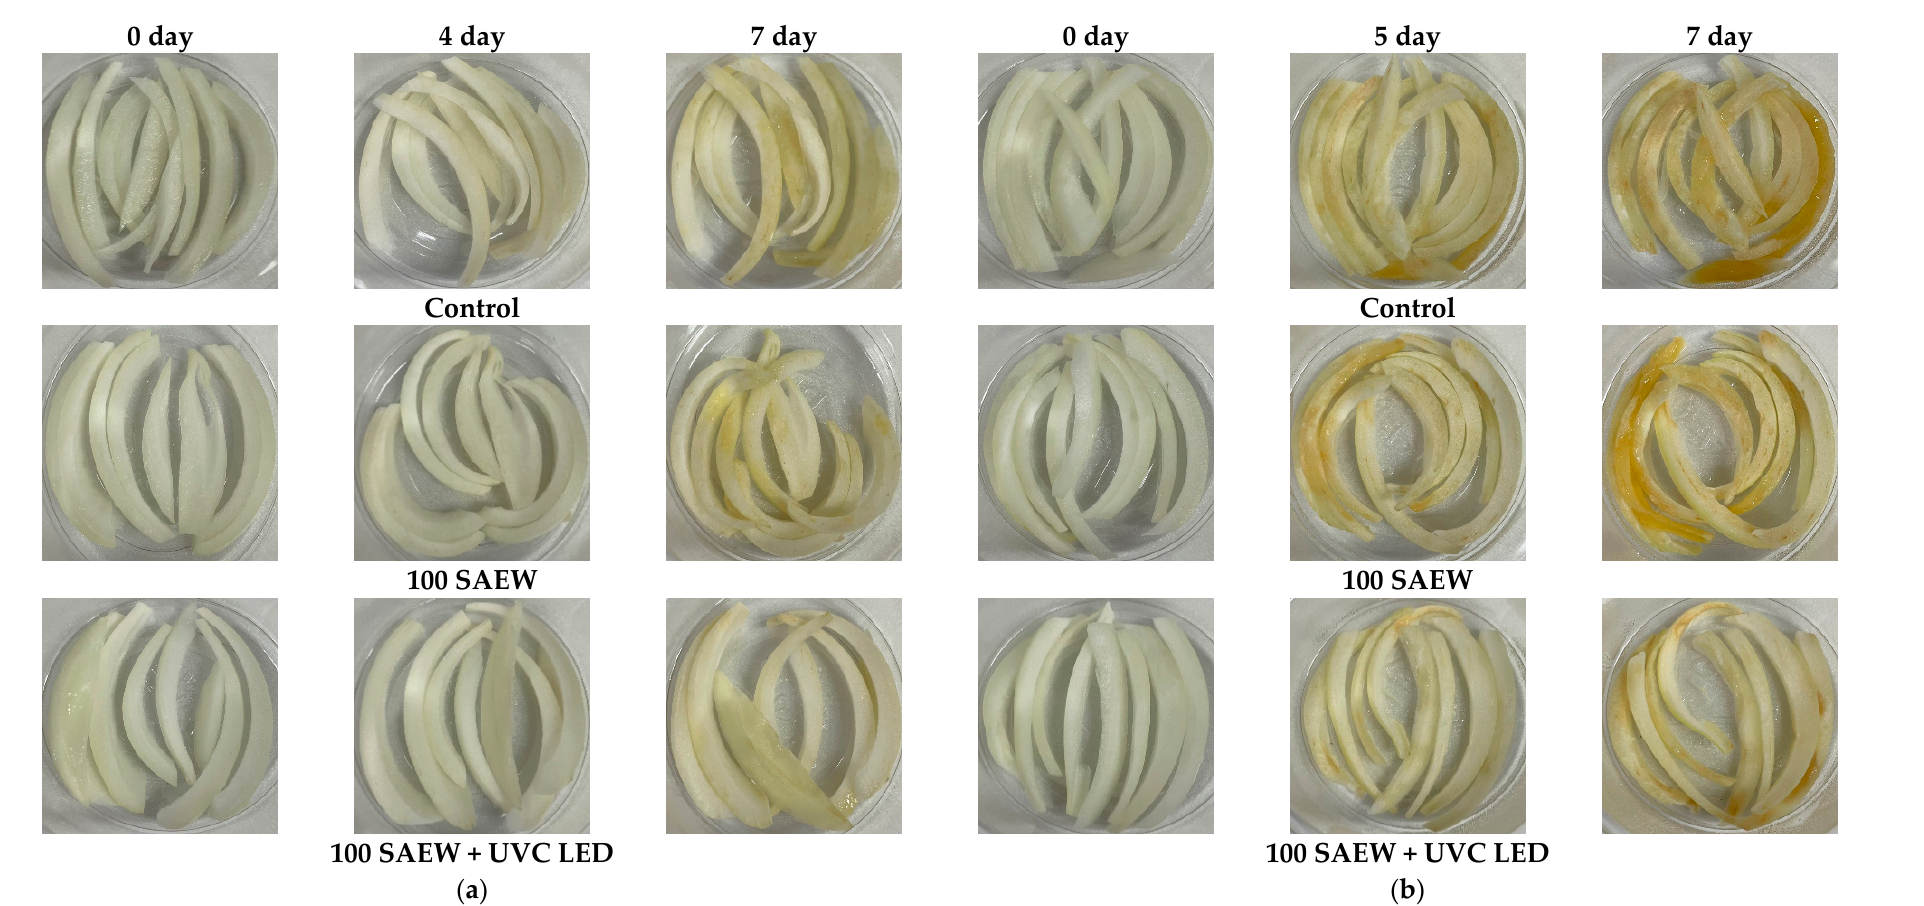
Figure 7. Visual appearance of sliced onions stored for 7 days at ( a ) 10 and ( b ) 15 °C. Control, no extra wash with sanitizer; 100 SAEW, aerosolization with 100 ppm SAEW; 100 SAEW + UVC LED, aerosolization with 100 ppm SAEW and UVC LED irradiation (275 nm) for 3 min.